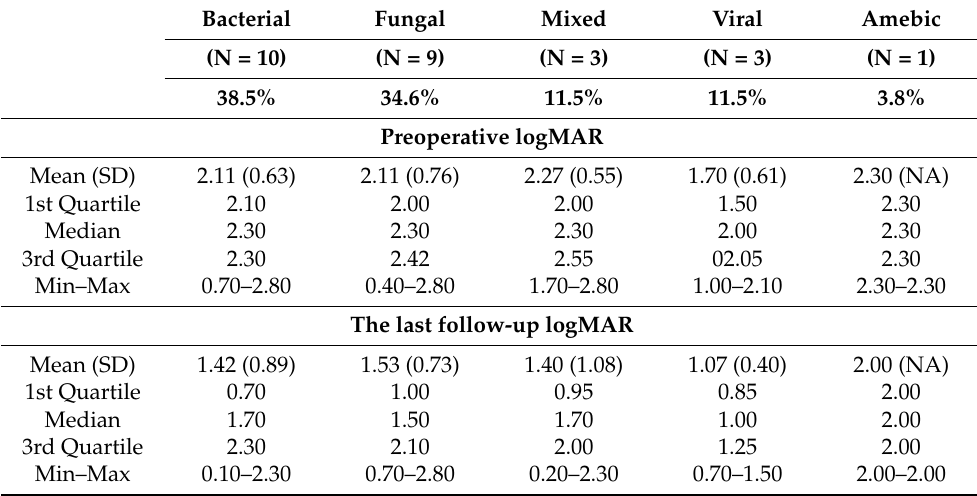
Table 6. Summary of visual outcomes for each type of